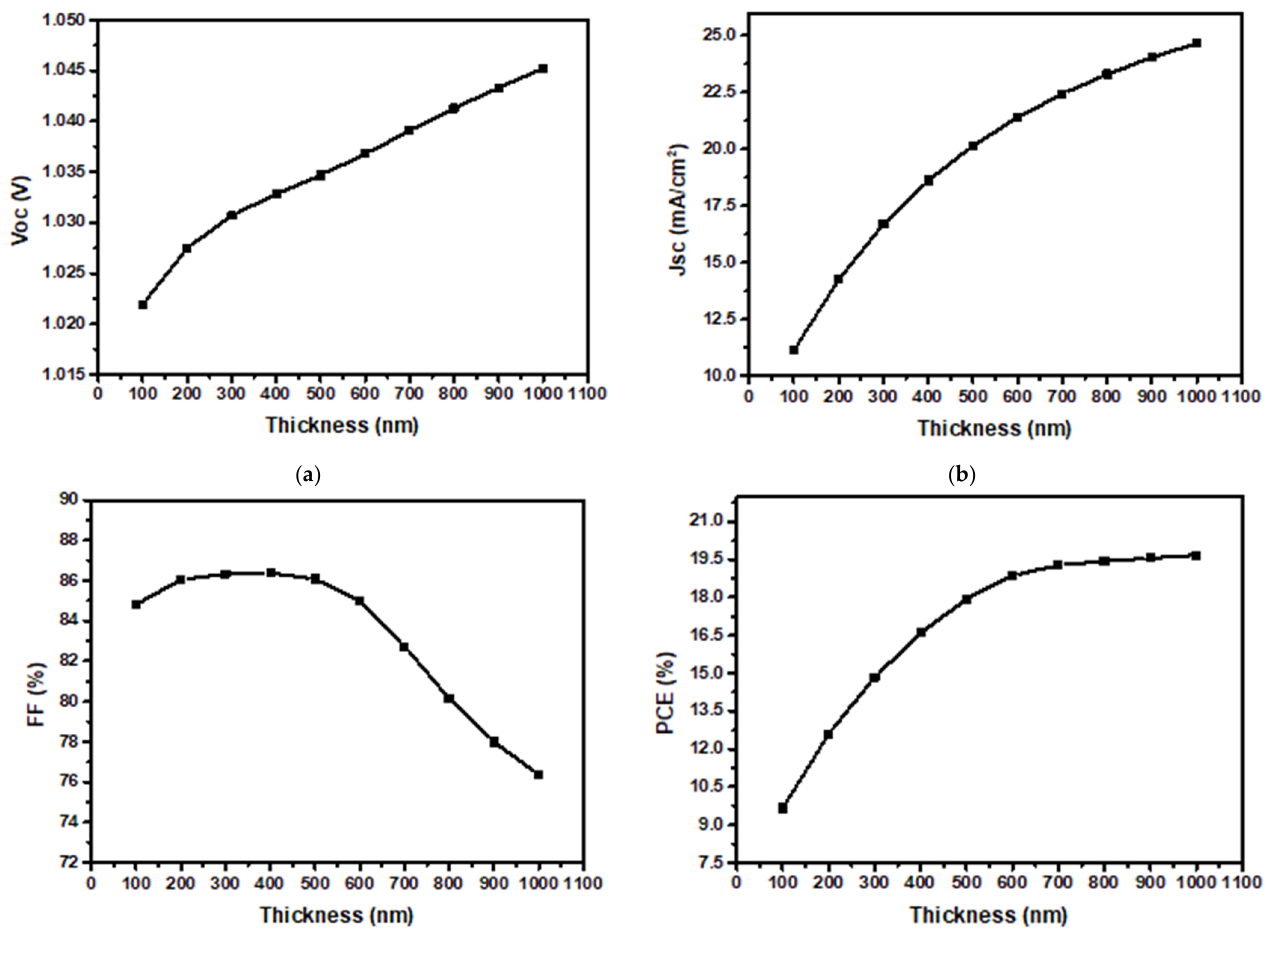
Figure 4. Current density–voltage ( J–V ) curves for various PAL thicknesses.